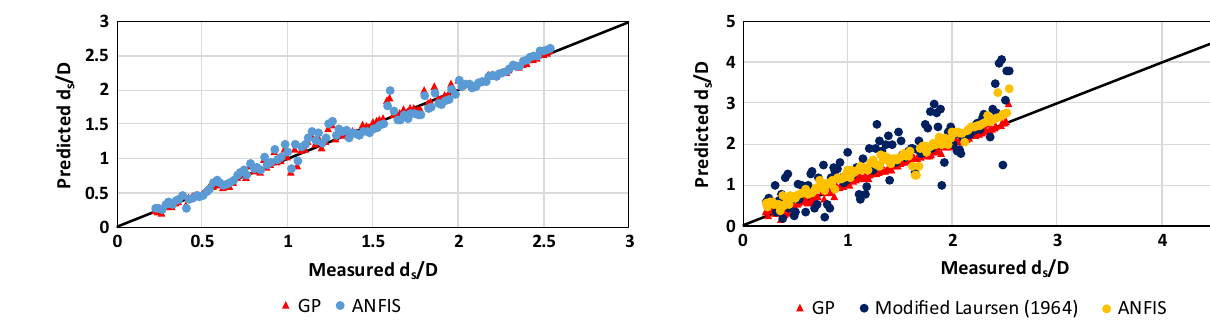
D versus Modified s /